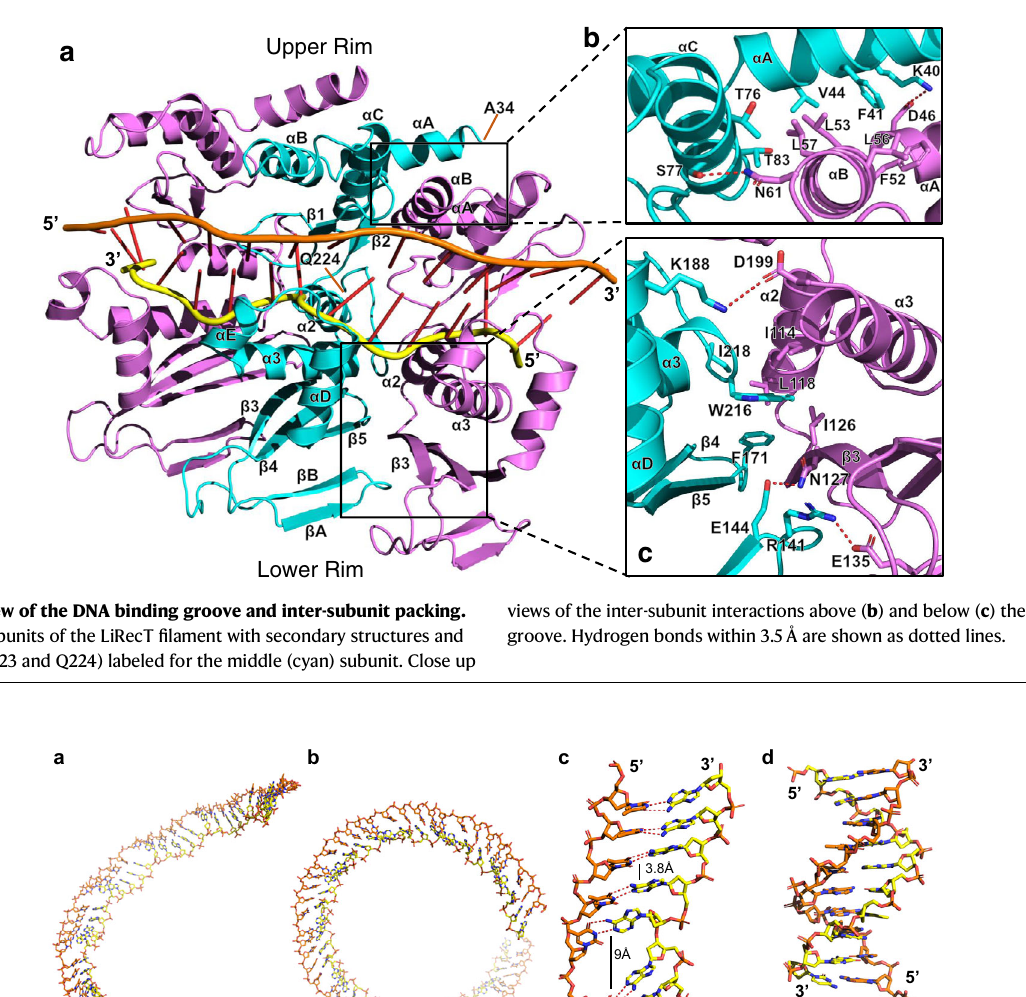
by3.8Åexceptatevery5thbpstepwheretheyareopenedto9Åbyinsertionofthe β 1- β 2hairpin. d 10bpofB-formDNAdrawntoscaleforcomparison.Coordinatesof B-DNA are from PDB code 1BNA 50 . Notice that the duplex intermediate from the LiRecT fi lament is highly extended and unwound, but still forms normal Watson- Crick base pairs, as indicated by the dotted lines.